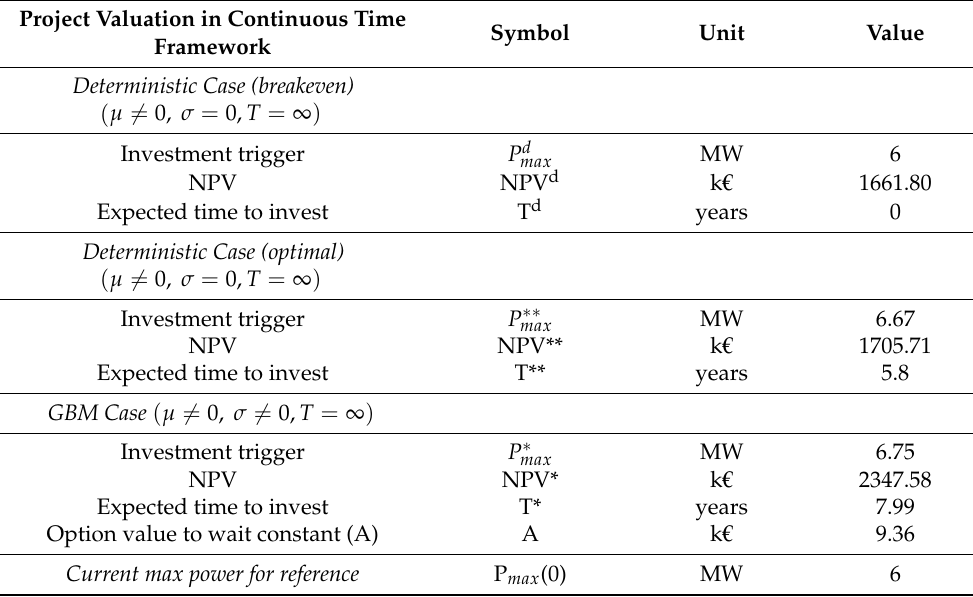
Table 3. Thresholds and option values for the decision to